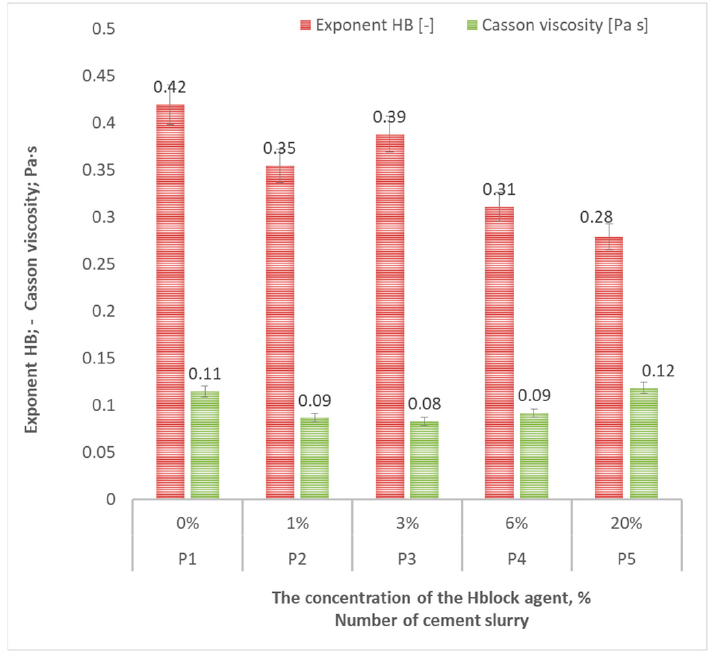
Figure 16. Summary of selected test results for rheological parameters of cement slurries (cement class CEM I 42.5R).